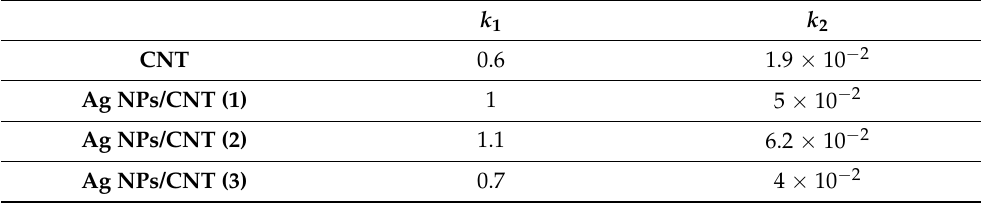
Figure 9. ( a , b ): Different kinetic models for CNTs and their decoration with different amount from Ag NPs. Table 2. The kinetic constants (k 1 ) and (k 2 ) for the prepared samples.